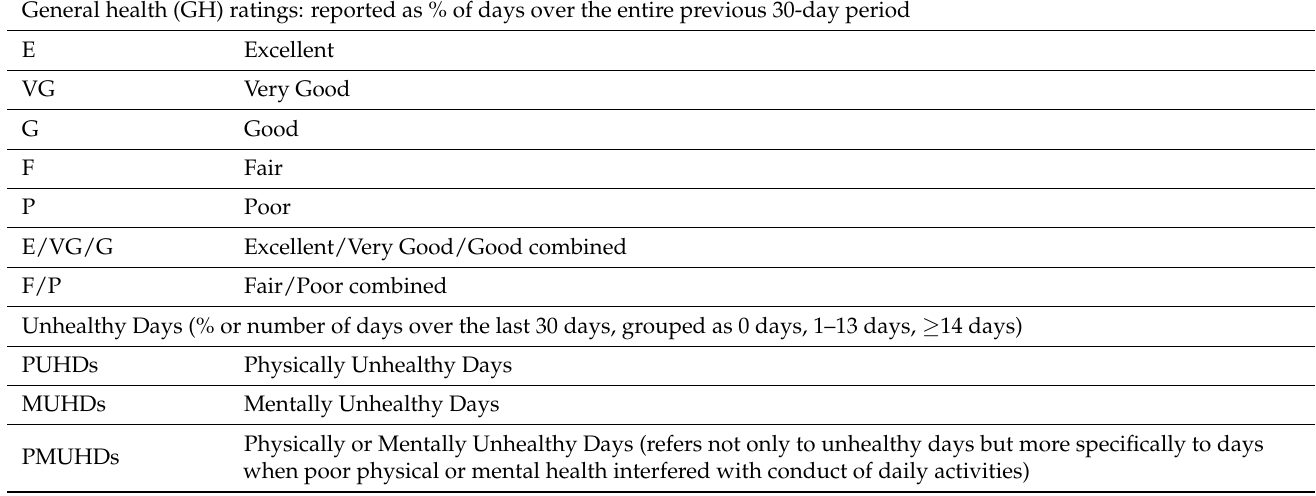
Table 1. Summary of types and abbreviations of self-reported responses to the BRFSS Healthy Days questions. General health (GH) ratings: reported as % of days over the entire previous 30-day